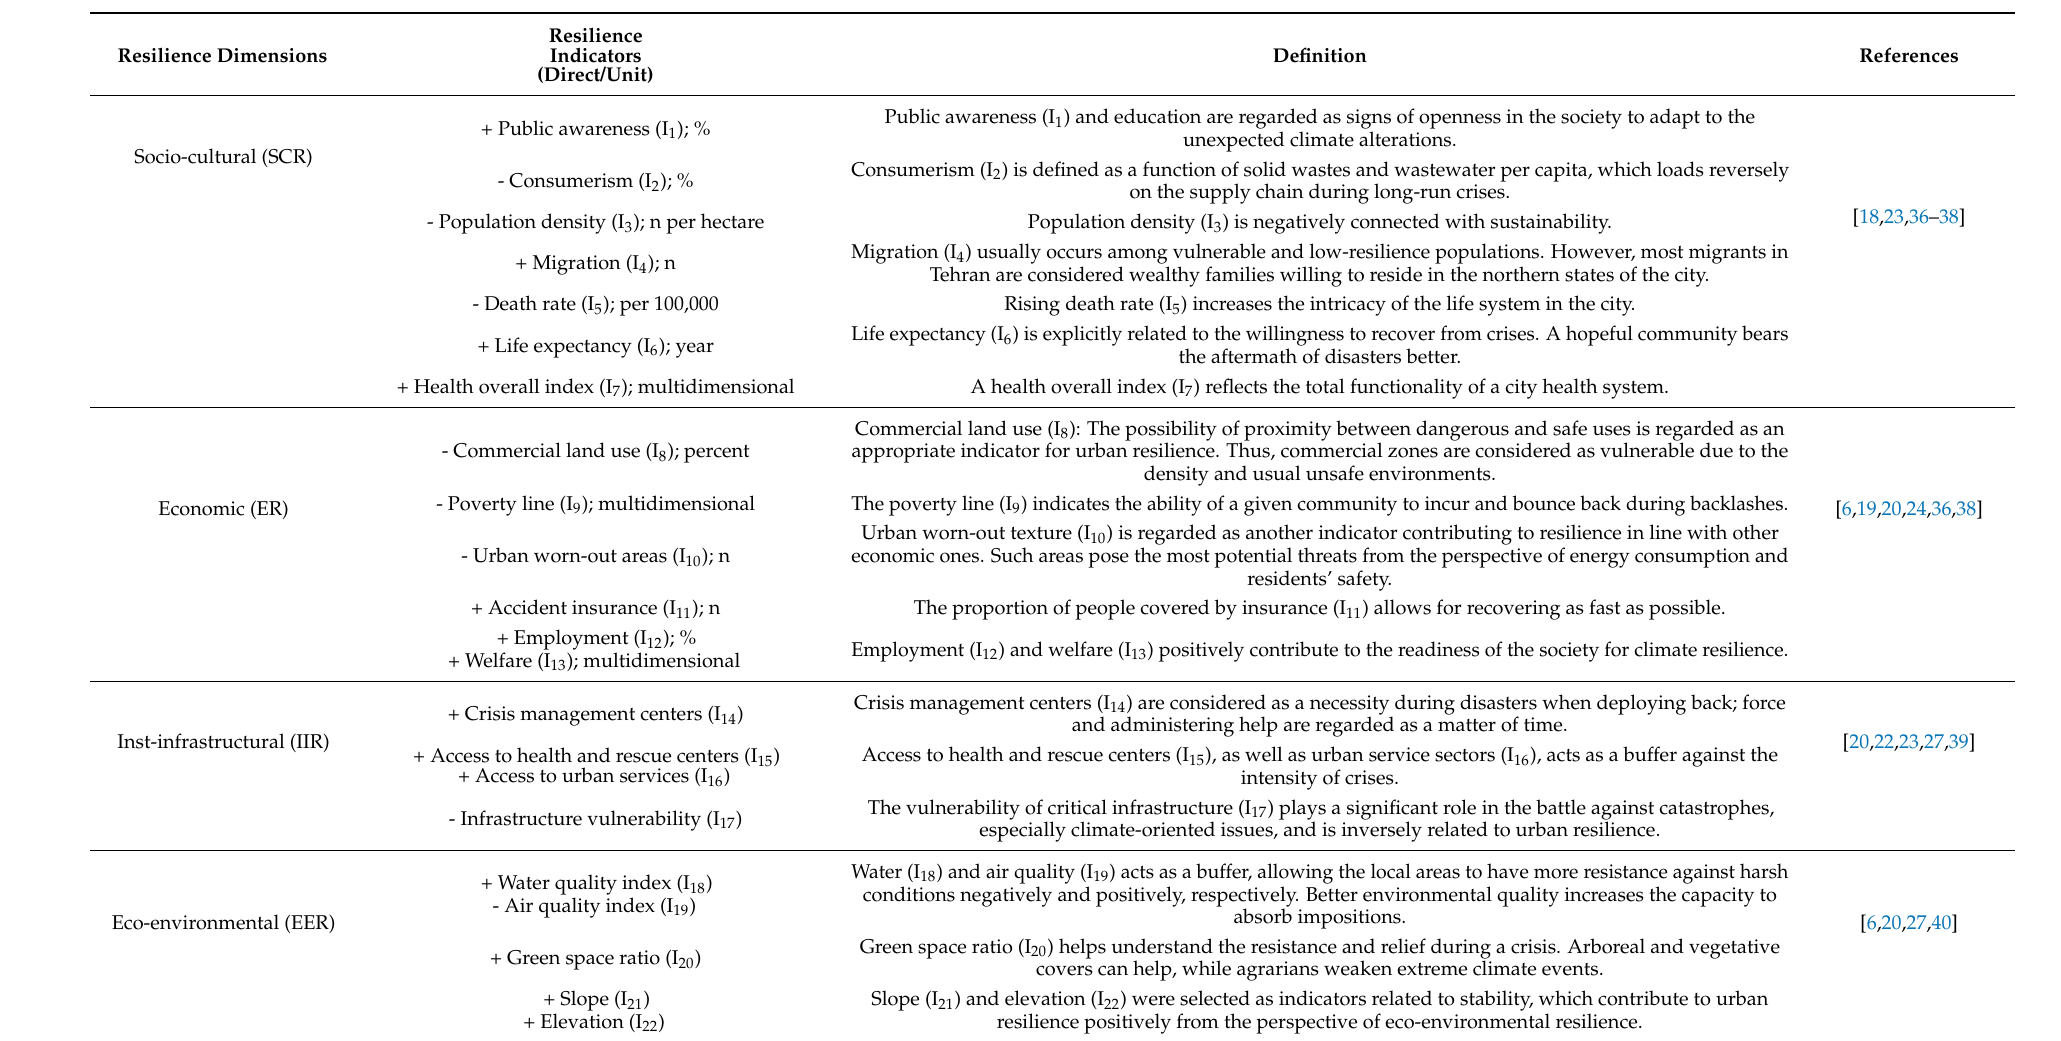
Table 1. A list of dimensions, indicators, and their